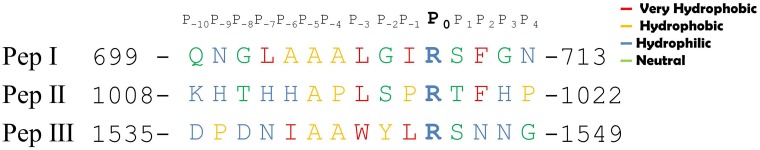
Sequences from factor V containing thrombin cleavage site: Coloured as per hydrophobic property.The position of Arg, which is the cleavage site, is named P0 (shown in Bolds). It is notable that hydrophilic residue at P2 & P3 and hydrophobic residue at P-2 & P-3 is only in Peptide III.